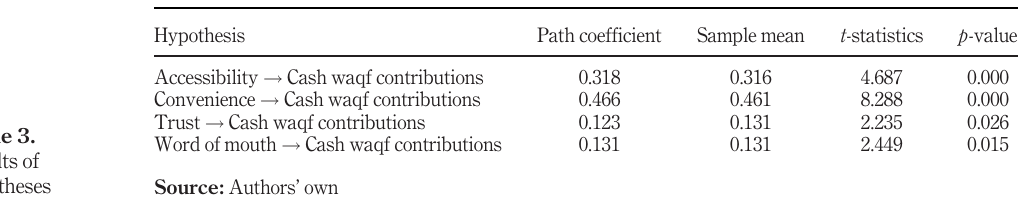
Table 3. Results of